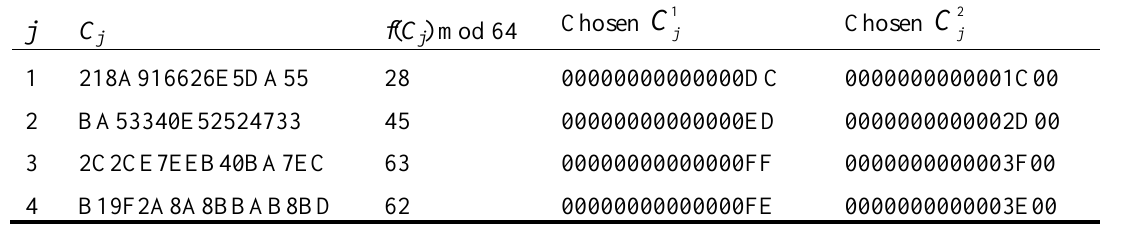
Table 3. The chosen C 1 and C 2 of C